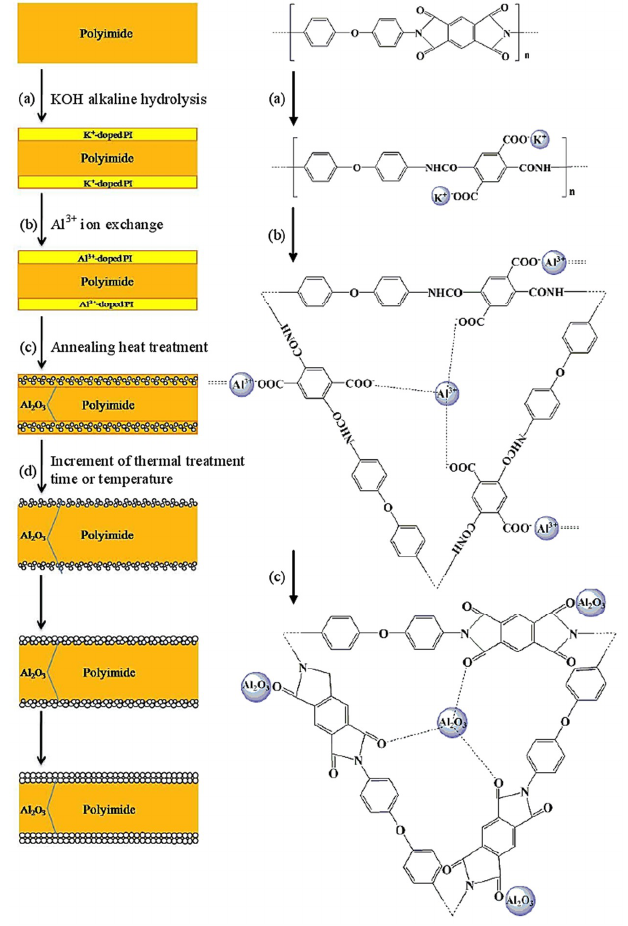
Figure 2. Schematic diagram of the reaction process for the Kapton/Al 2 O 3 nanocomposite film prepared via the surface-modification-ion-exchange method.